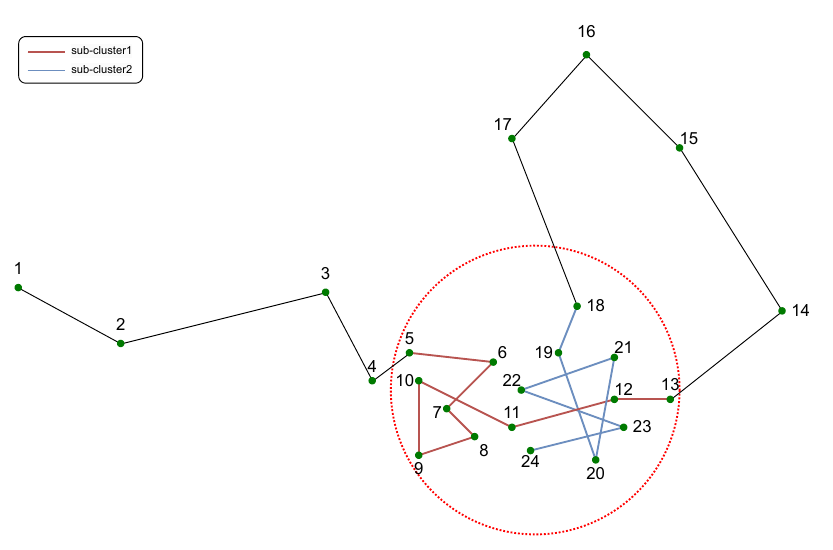
Figure 4. An example of interactions between sub-clusters in clustering